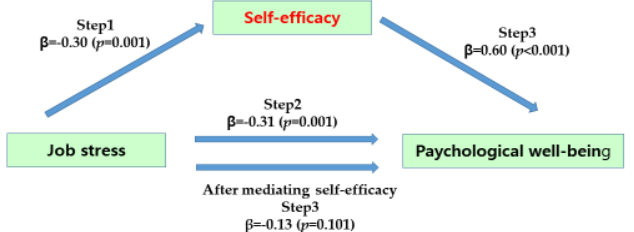
Figure 1. Mediating effect of self-efficacy of participants.